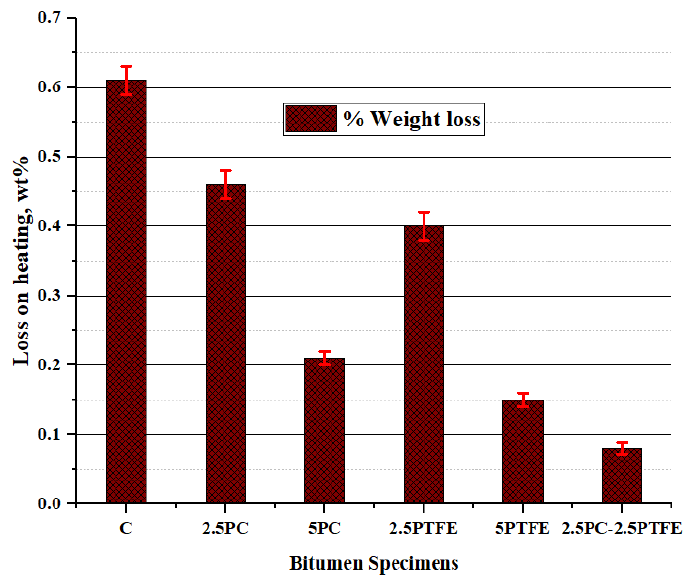
Figure 5. The weight loss on heating of the binders after RTFOT.